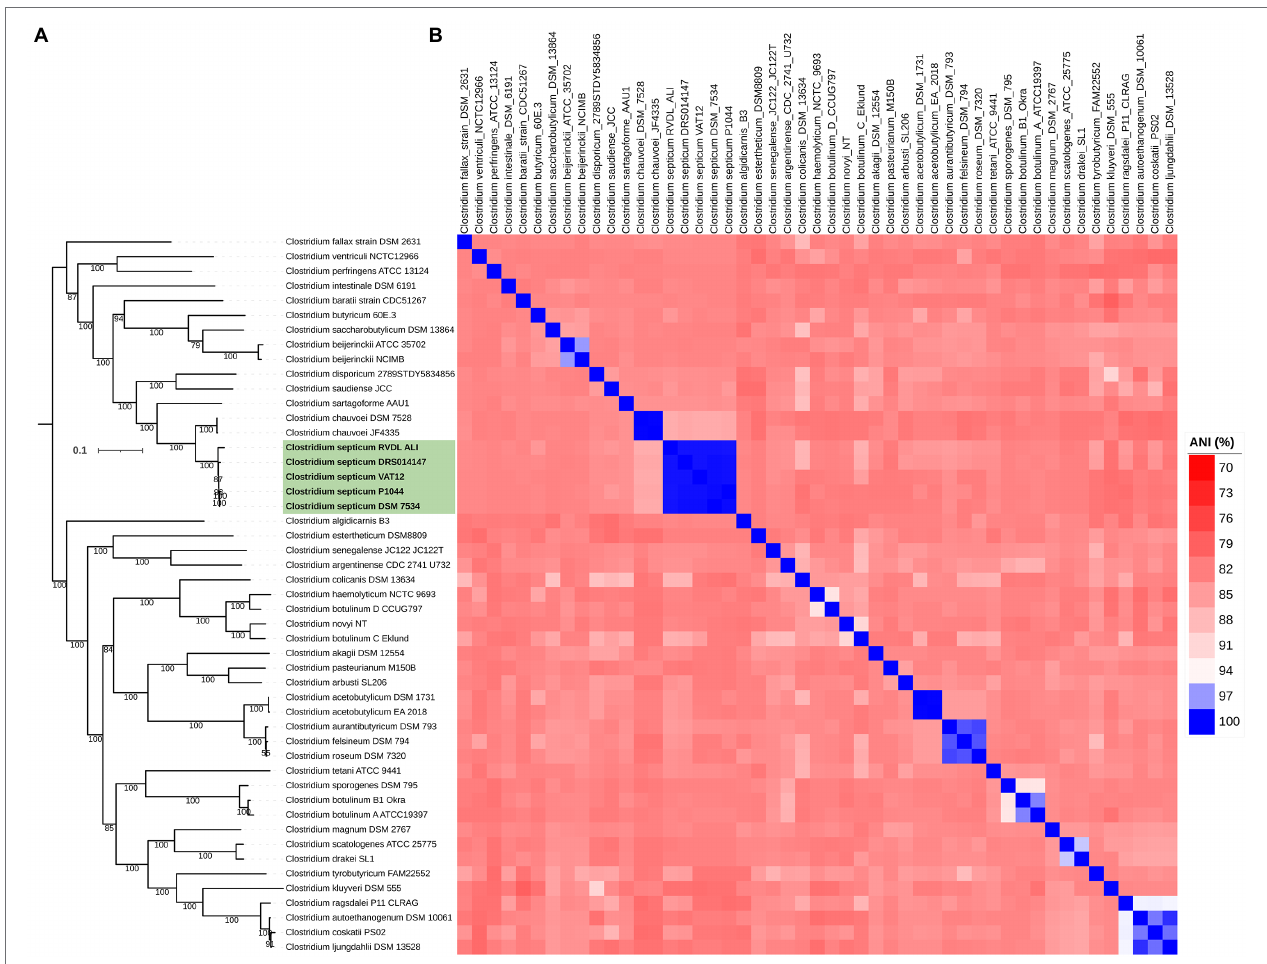
FIGURE 2 | Taxonomic classification of C. septicum based on genome-wide approaches. Representative genomes of the Clostridium genus cluster 1 ( Clostridium sensu stricto ) were involved in the analysis. (A) Maximum likelihood tree based on PhyloPhlAn. (B) Pairwise average nucleotide identity (ANI) between the genomes.